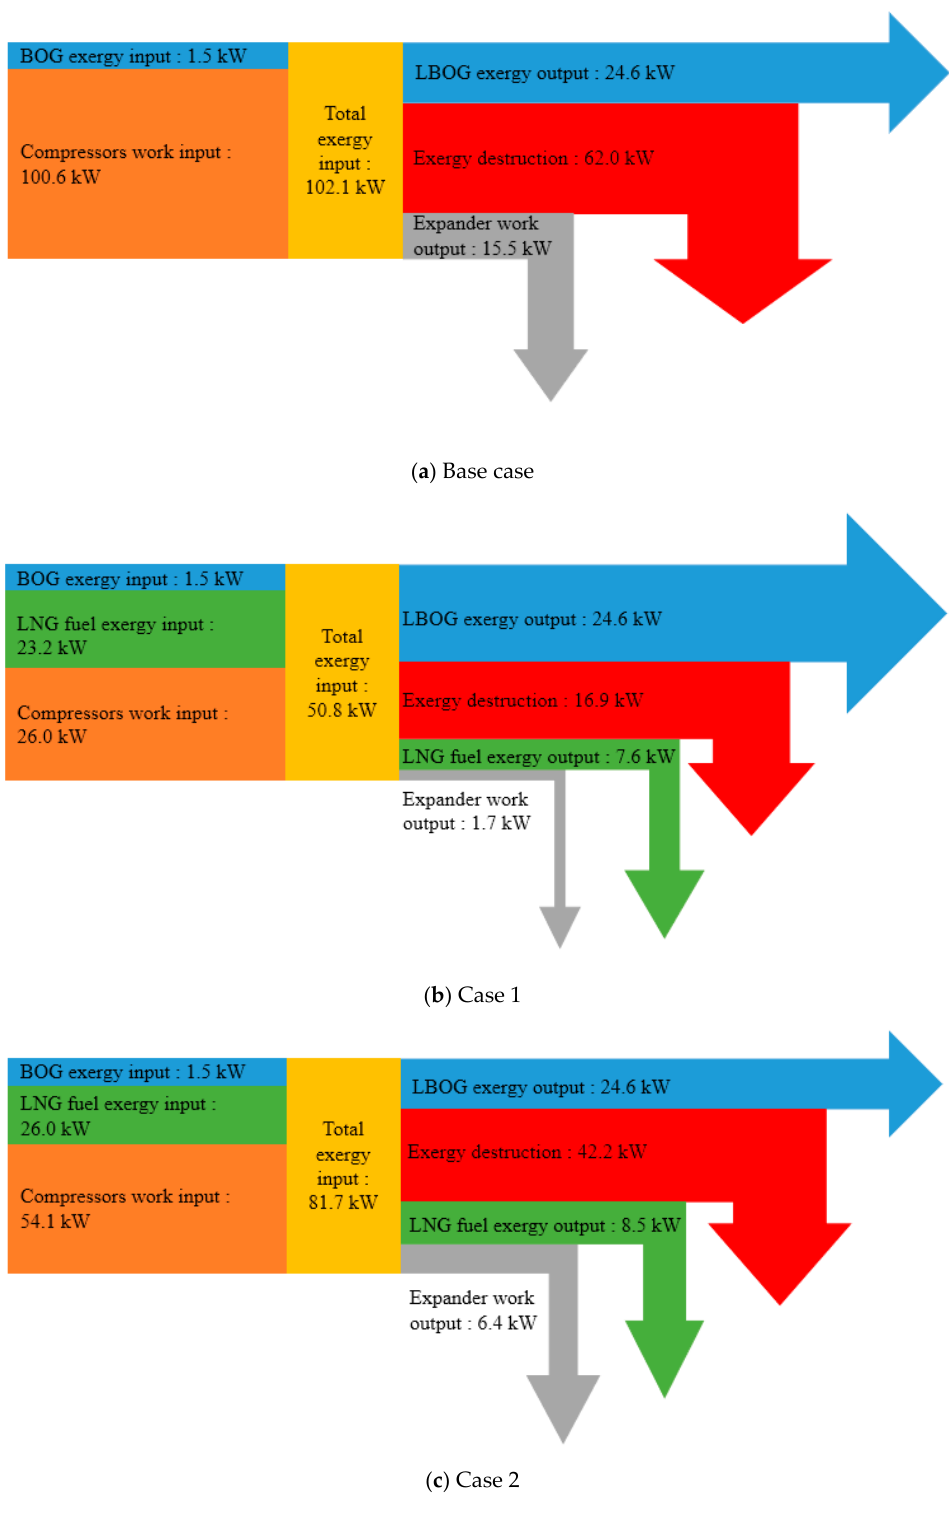
Figure 16. Exergy flow of the optimized systems: ( a ) Base case, ( b ) Case 1, ( c ) Case 2.